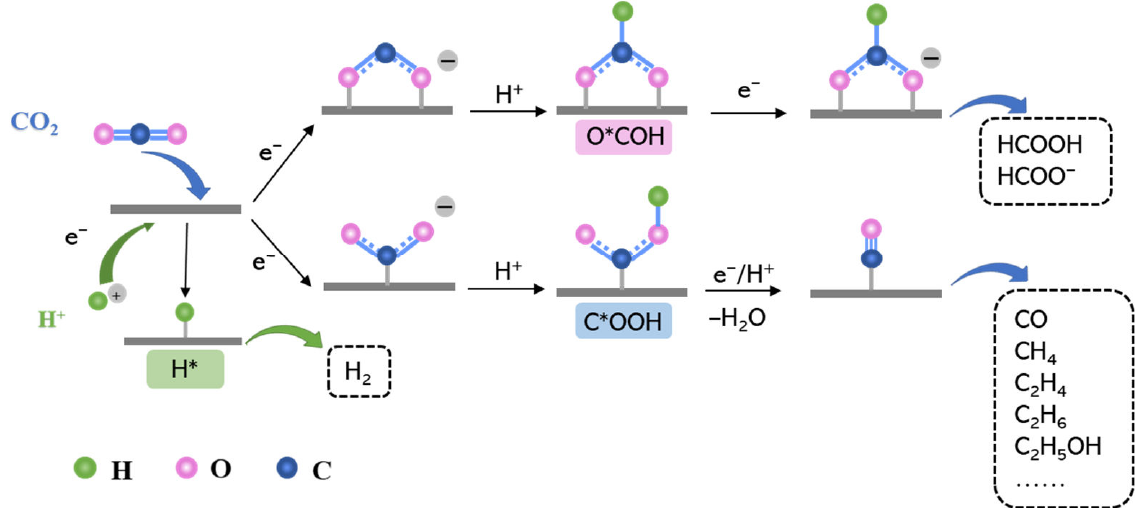
Figure 1. The main intermediates of C*OOH and O*COH for the CO 2 reduction reaction (CO 2 RR) and the H* intermediate for the hydrogen evolution reaction (HER).